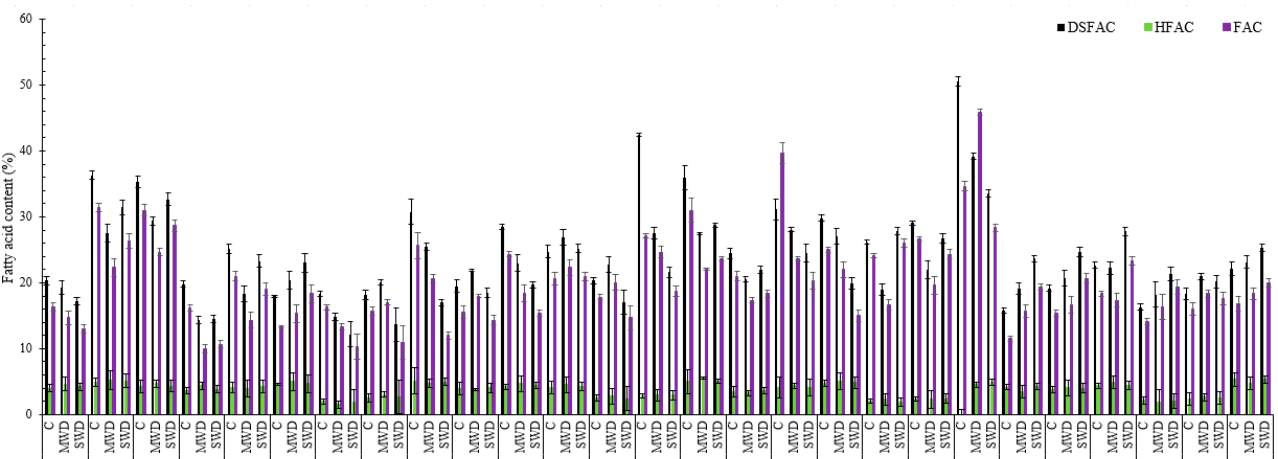
Figure 5. Water treatment (WT) × genotype interaction effect on the percent of seed hulls (POSH) and percent of dehulled seed (PODS). C: control; MWD: moderate water deficit; SWD: severe water deficit. L 1 –L 3 : 3 testers, G 1 –G 6 : 6 male parents;